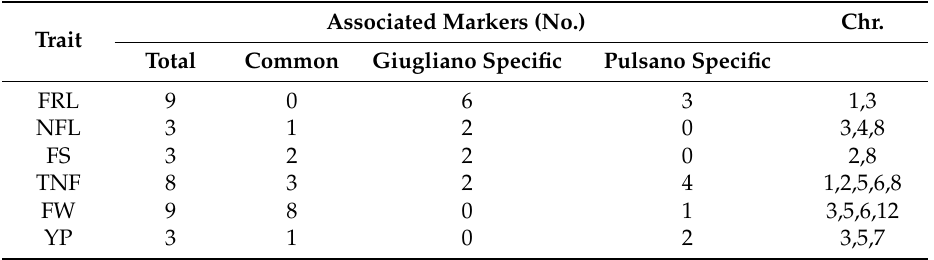
8 0 1 3,5,6,12 YP 3 1 0 2